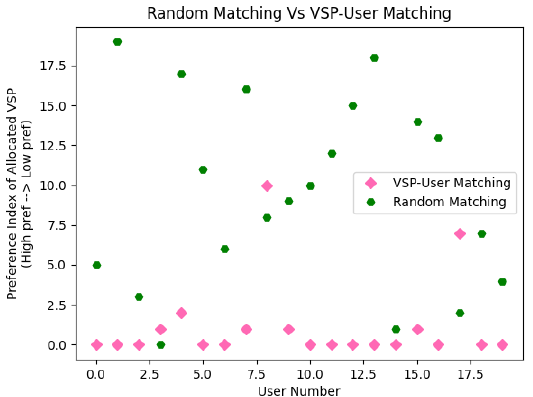
Figure 8. Two-dimensional plot of users vs. the preference index of the VSP that is allocated to Figure 8. 2-dimensional plot of Users vs the preference index of the VSP that is allocated to them.